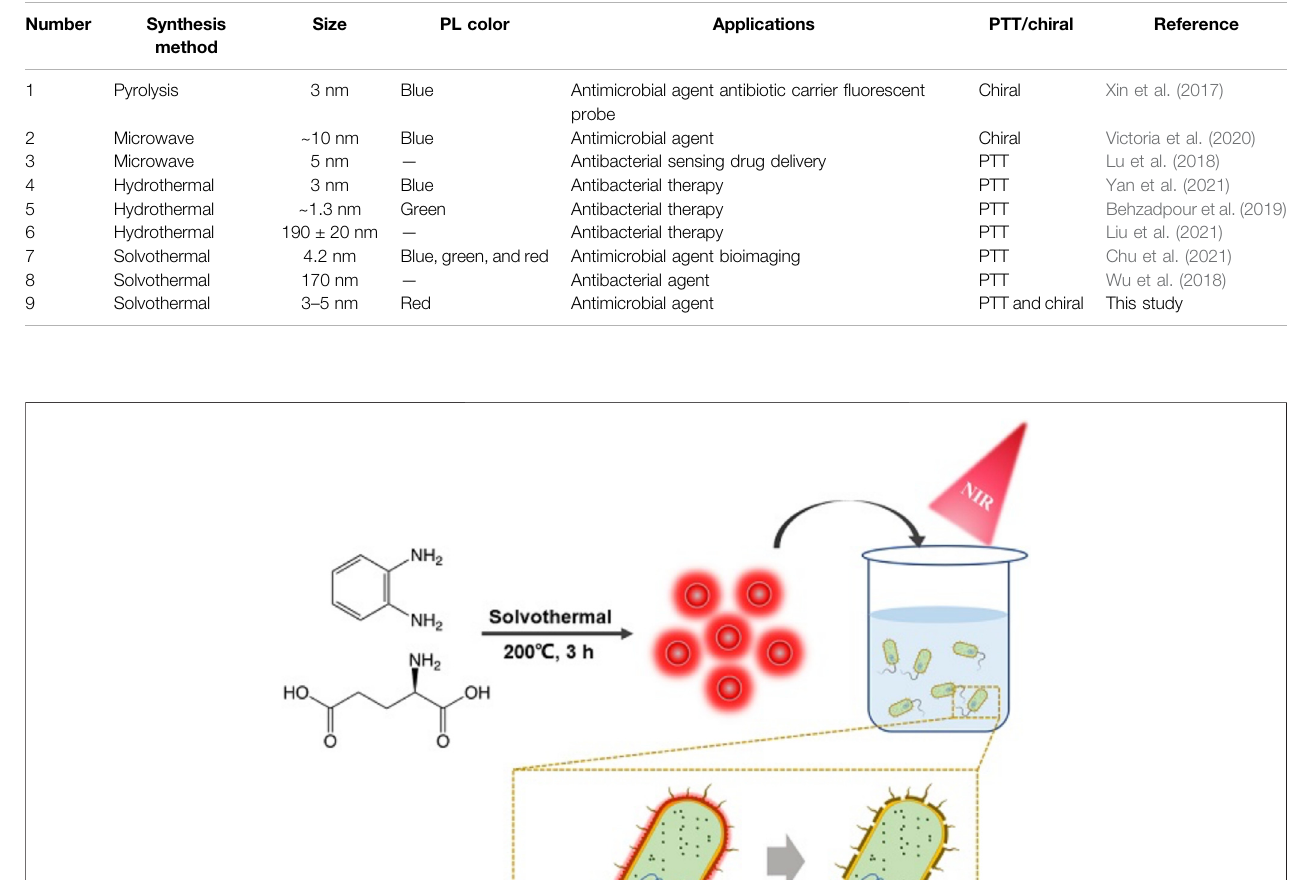
TABLE 1 | Antibacterial carbon dots with the chiral structure or PTT in recent years.